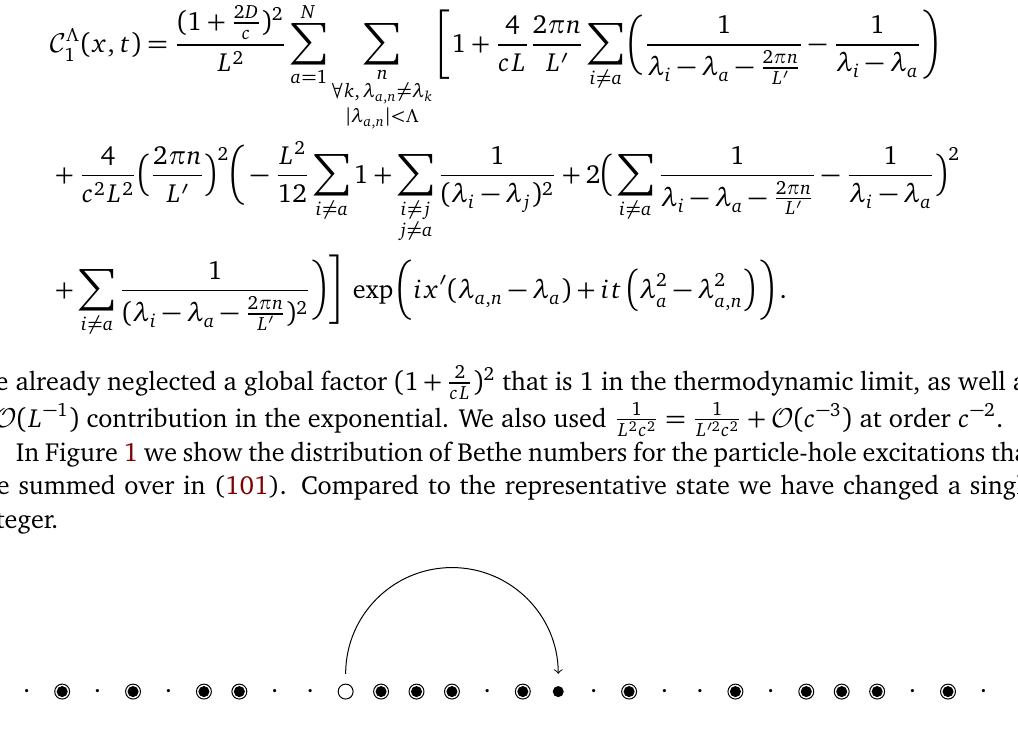
Figure 1: Sketch of a one-particle-hole excitation: positions of the momenta of the representative state (empty circles) and the intermediate state (filled circles) respec- tively, and position of the holes